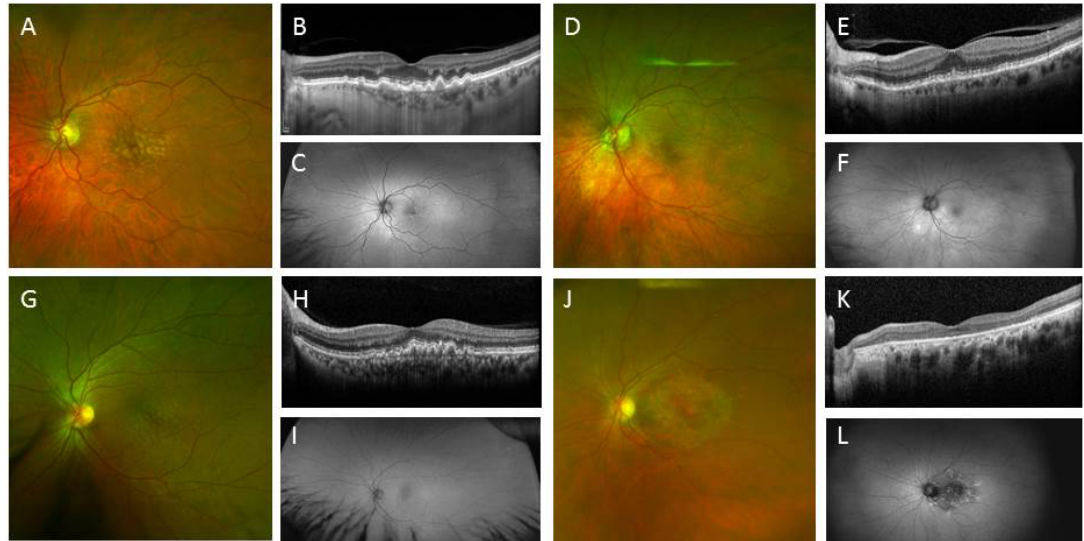
Figure 5. Clinical images of early age-related macular degeneration and its variants. ( A ) Colour photograph of the macula of a 72-year-old male showing soft drusen; ( B ) Optical coherence tomography (OCT) shows a sub-retinal pigment epithelial (RPE) deposit, which did not significantly alter fundus autofluorescence ( C ); ( D ) Colour photograph of the macula of a 78-year-old female showing reticular pseudo-drusen; ( E ) OCT shows deposits above the RPE, resulting in subtle hypo autofluorescent lesions ( F ); ( G ) Colour photograph of the macula of a 57-year-old female showing basal laminar drusen; ( H ) OCT shows a compact sub-RPE deposit forming a saw-tooth pattern, and these lesions were mildly hyper autofluorescent ( I ); ( J ) Colour photograph of the macula of an 83-year-old female showing dominant drusen or Doyne honeycomb retinal dystrophy; ( K ) OCT shows outer retinal layer loss; ( L ) The fovea was hypo autofluorescent due to RPE loss, and the linear radial drusen are seen as hyper autofluorescent